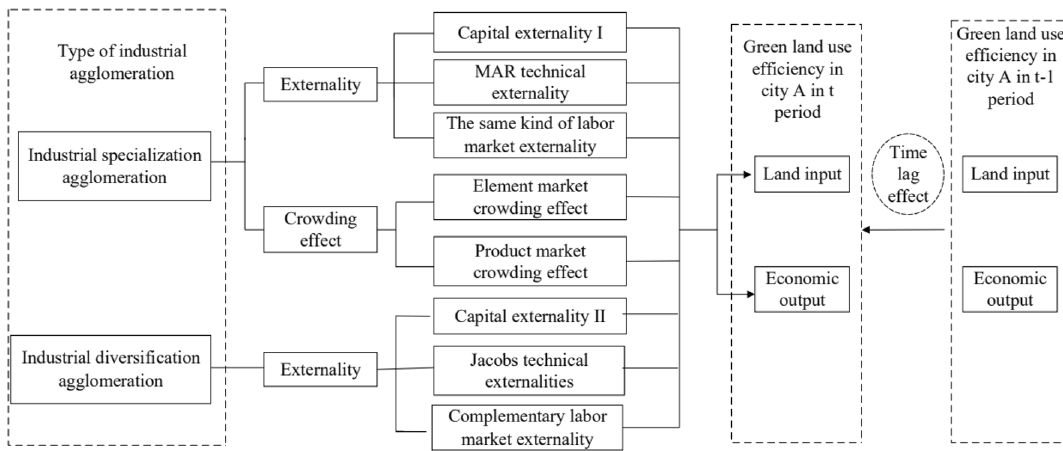
Figure 1. The impact mechanism of industrial agglomeration on